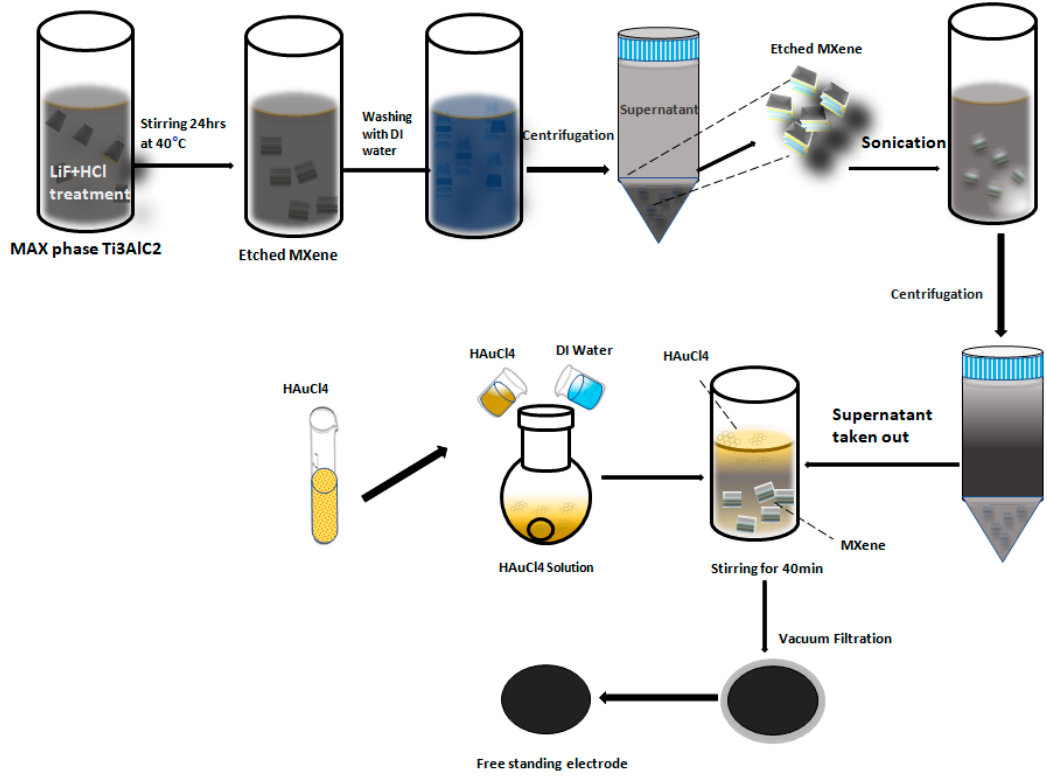
Figure 1. Schematic Illustration of the fabrication of MX/AuNPs free-standing film. The results of XRD characterization of Ti 3 AlC 2 , Ti 3 C 2 T x , and MX/Au are presented in Figure 2. The characteristic peaks of Ti 3 AlC 2 at 9.43° with d-spacing of 5.4° and 38.82° are at (002) and (104) locations of crystal planes. After the etching and delamination proce- dure, the strong peak (104) vanished, indicating that the aluminum (Al) atomic layer of Ti 3 AlC 2 was successfully etched. The angle of the MXene peak (002) is 6.44°, which is lower than that of Ti 3 AlC 2 at 9.43°, demonstrating that, following the etching and delamination process, the space between layers has been increased. The sharpness of the (002) peak, which stays prominent, indicates that the generated MXene has a higher degree of crys- tallinity and a well-ordered structure. The (002) peak location of MXene in MX/Au film remained unaltered, showing that MXene exists, but there is no gold incorporated into the MXene lattice [43]. Further, nanocomposite samples displayed the characteristic peaks at 2 θ = 38.2°, 44.4°, 64.6°, 77.5°, and 81.7°, which are attributed to crystal planes of (111), (200), (220), (222), and (331) face-centered cubic (fcc) AuNPs (JCPDS no. 04–0784) [44]. The nanocomposite samples of XRD patterns demonstrate that AuNPs were successfully pre- pared.